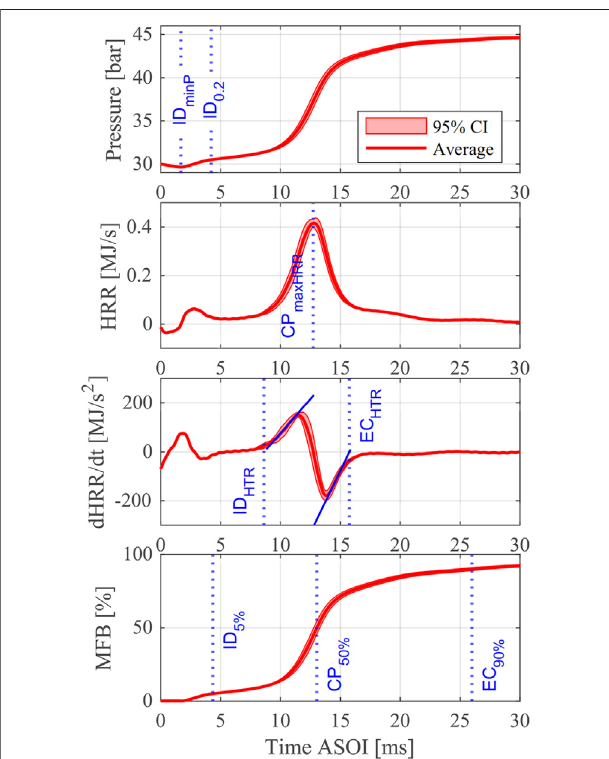
FIGURE 4 | Pressure, HRR, dHRR/dt, and MFB results of EHN-4 for T wall = 550 ° C. The red solid curve shows the ensemble-averaged result from fi veinjections,whileredshadedregionsrepresentthe95%con fi denceinterval for each averaged result. The combustion indicators are shown by blue dashed lines.Twosolidblue lines inthe dHRR/dt panel arethe linear fi tsofthe two positive slopes of the dHRR/dt pro fi le within the high-temperature reaction phase,